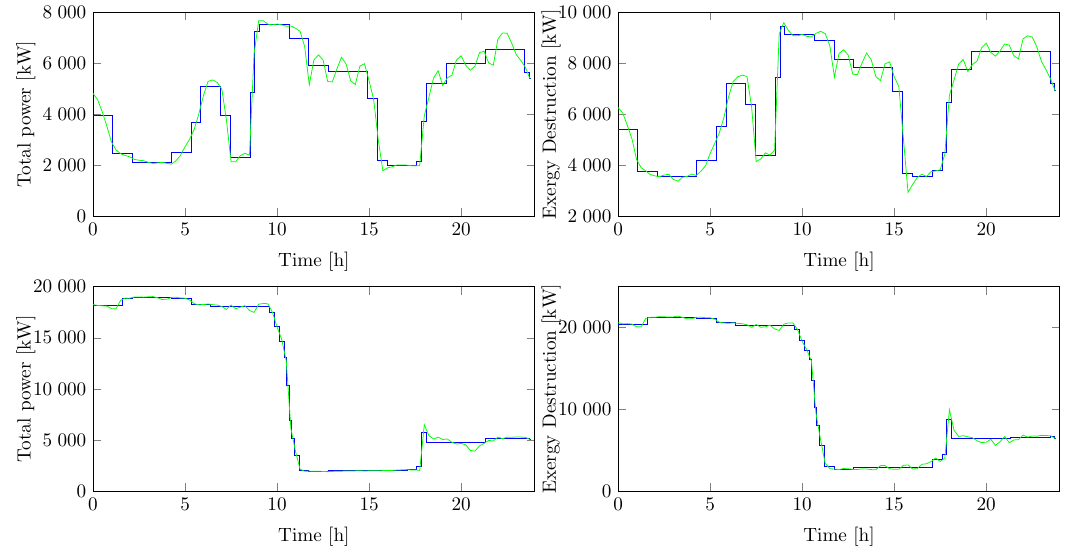
Figure 23. Power ( left ) and exergy destruction ( right ) profiles, original (green) and segmented (blue), for the 2 typical days and duration